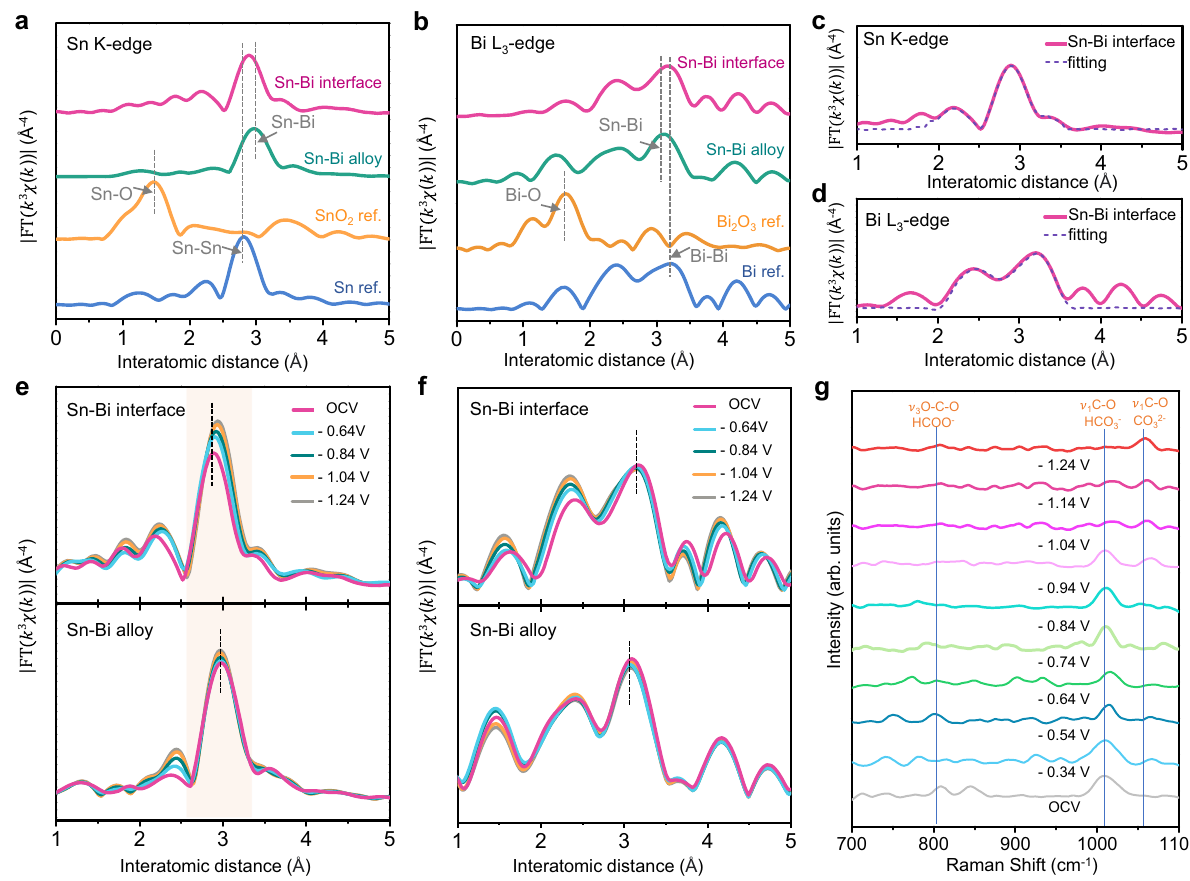
Fig. 4 Characterizations of local atomic structures and the chemical environment by EXAFS. a , b Fourier-transform k 3 -weighted EXAFS spectra of Sn K-edge and Bi L 3 -edge of Sn – Bi alloy, bimetallic interface materials and reference samples. c, d Representative fi tting of the EXAFS spectra to the R space of Sn K-edge and Bi L 3 -edge of Sn – Bi bimetallic interface materials. e, f In situ Fourier-transform k 3 -weighted EXAFS spectra for Sn K-edge and Bi L 3 -edge of Sn – Bi interface and alloy samples, respectively, at different applied potentials during CO 2 RR. g In situ Raman spectroscopic study on the intermediate adsorption for Sn – Bi interface sample at various potentials vs.